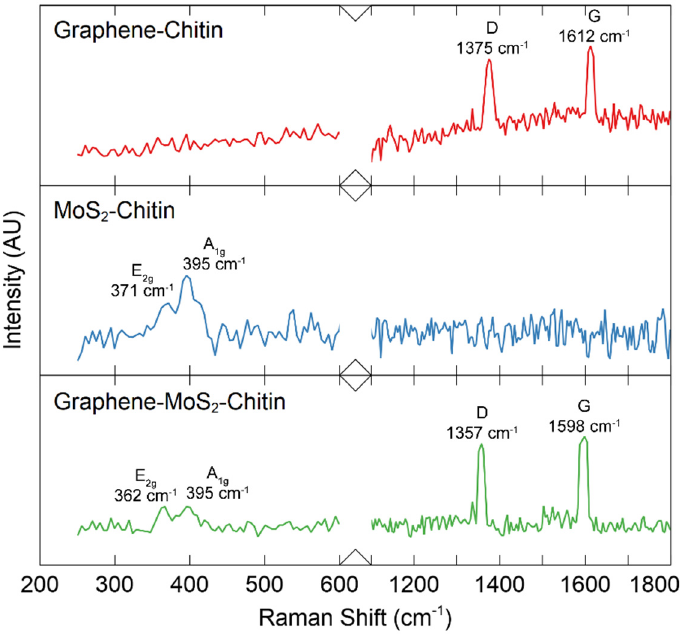
Figure 7. Raman spectrum of the fabricated graphene ‒ chitin, MoS 2 ‒ chitin, and graphene ‒ MoS 2 ‒ SA Chitin SA films.